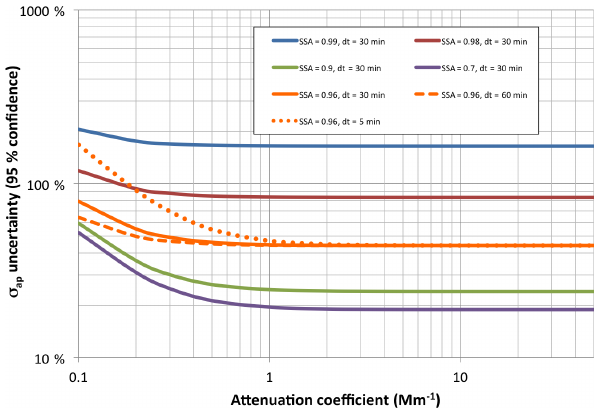
Figure 8. Uncertainty of CLAP measurements of the absorption co- efficient (95% confidence level) as a function of the attenuation co- efficient, for various values of the single-scattering albedo (SSA) and averaging time (dt). Solid lines are all for 30min averaging time, dashed lines are for other averaging times as noted in the leg- end.